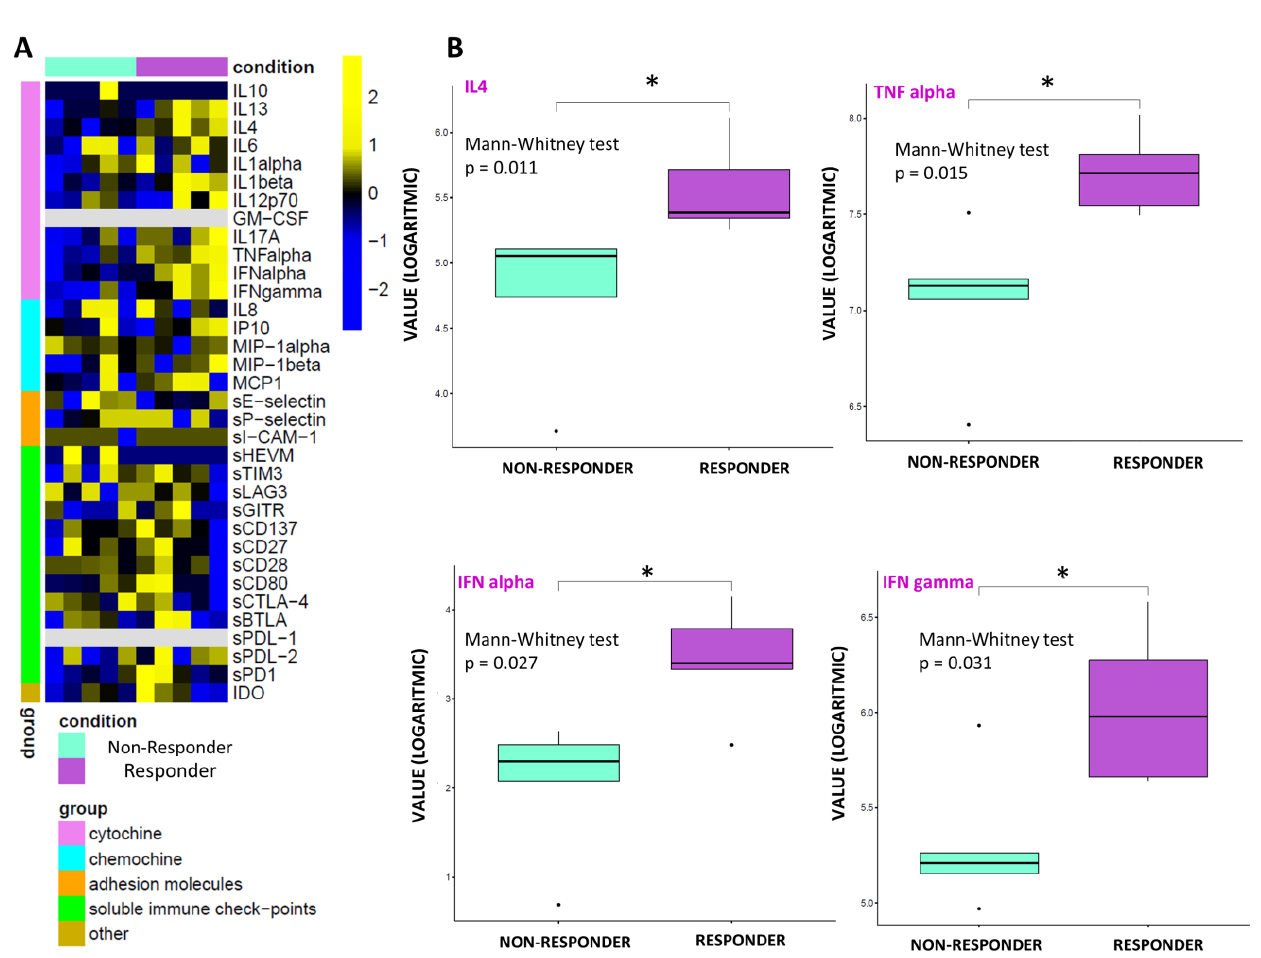
Figure 2. Statistical analysis at T1. ( A ) Heatmap of molecule expression levels (logarithmic scale) at T1 across 10 patients, grouped by therapy responder (violet bars) and non-responder (water blue bars). Colors represent different expression levels, increasing from blue to yellow. ( B ) Boxplot of molecule expression levels (logarithmic scale) in 5 responder patients (violet box) and 5 non-responder ones (water blue box) at T1. p -values ( p ) were obtained by performing a Mann–Whitney test for unpaired samples. Only molecules showing a statistically significant difference between the two groups are shown. Legend: * p ≤ 0.05.